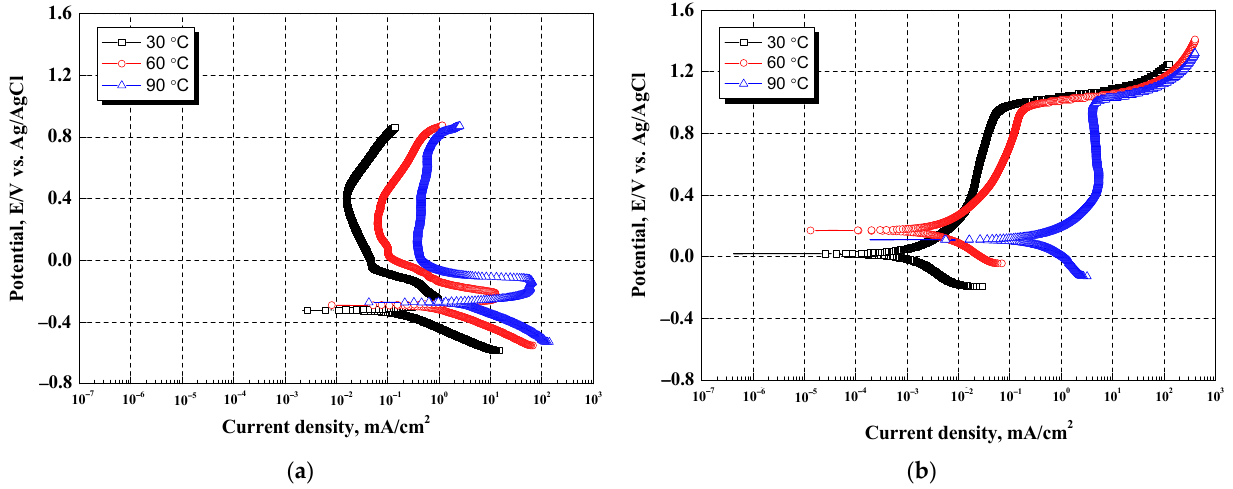
Figure 1. Potentiodynamic polarization curves of UNS S31603 and UNS N08367 in a modified green death solution. ( a ) Polarization curves for UNS S31603; ( b ) polarization curves for UNS N08367.